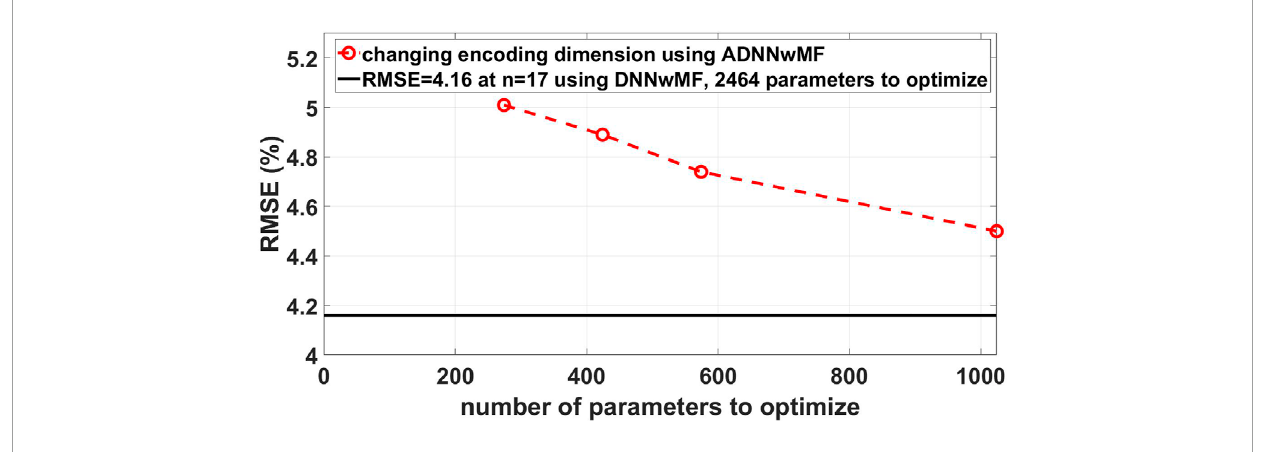
FIGURE 9 RMSE (%) vs. number of optimization